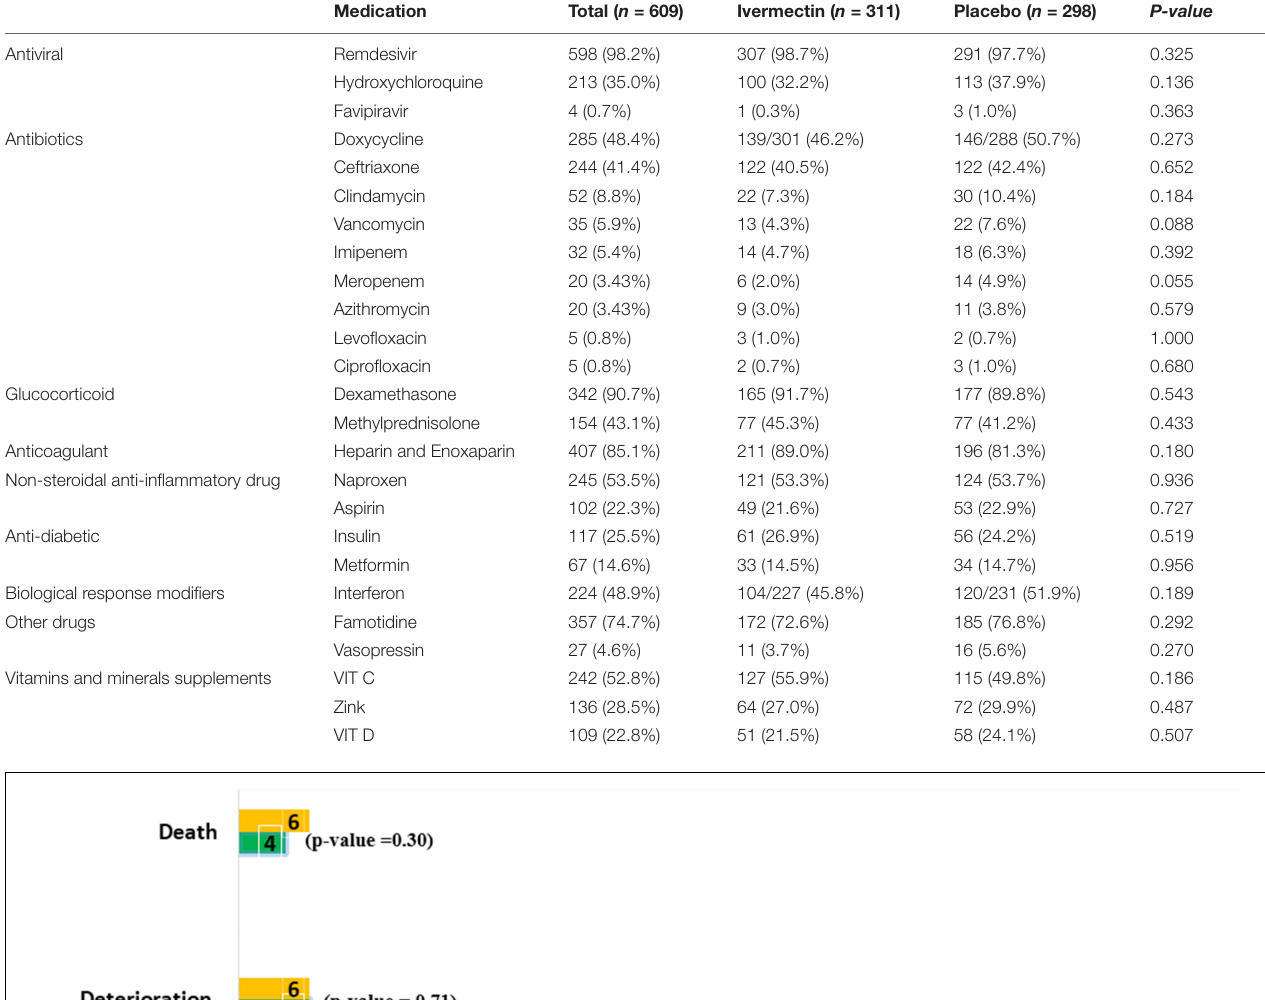
TABLE 3 | List of concomitant medications, vitamins and minerals supplements prescribed for inpatients.